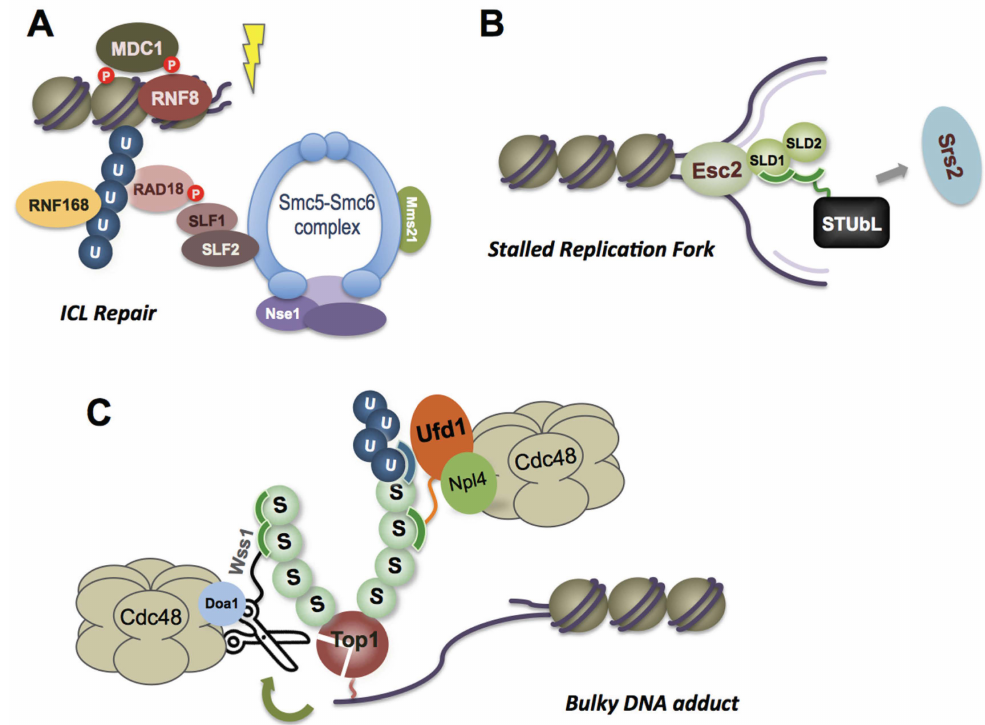
Figure 2. Examples of the Integration of SUMO and Ubiquitin Signaling. ( A ) Ubiquitin and SUMO E3s Nse1 and Nse2 are part of the chromatin-associated Smc5-Smc6 complex. Certain